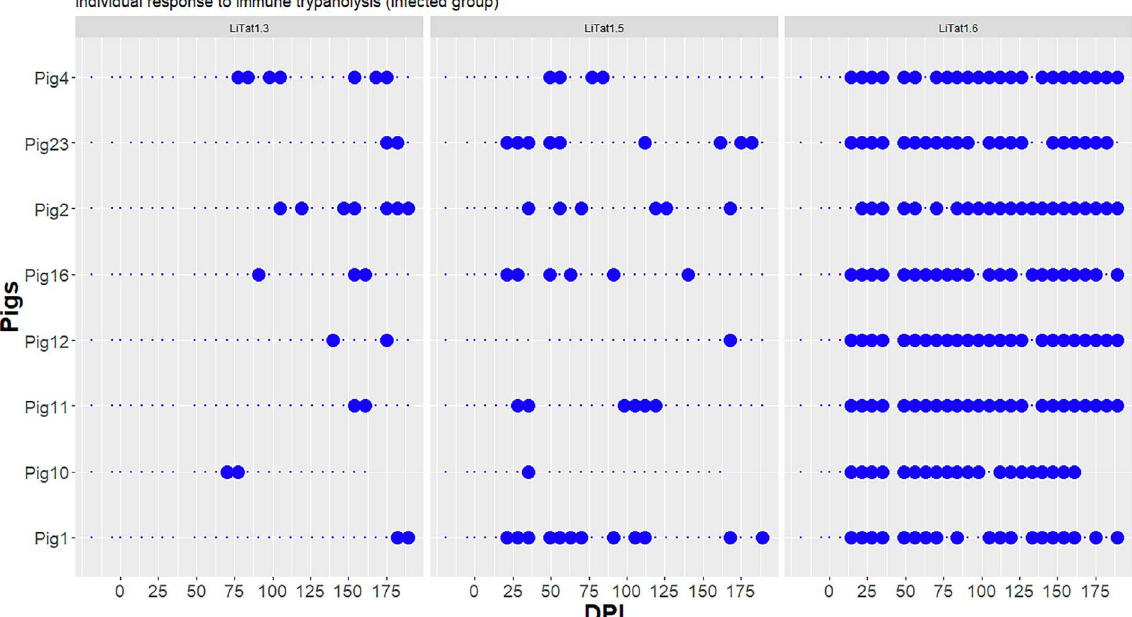
Figure 2. Individual trypanolysis tests (TL) results of infected pigs during the experiment. Large blue point: TL positive; small blue point: TL negative; dpi: days post